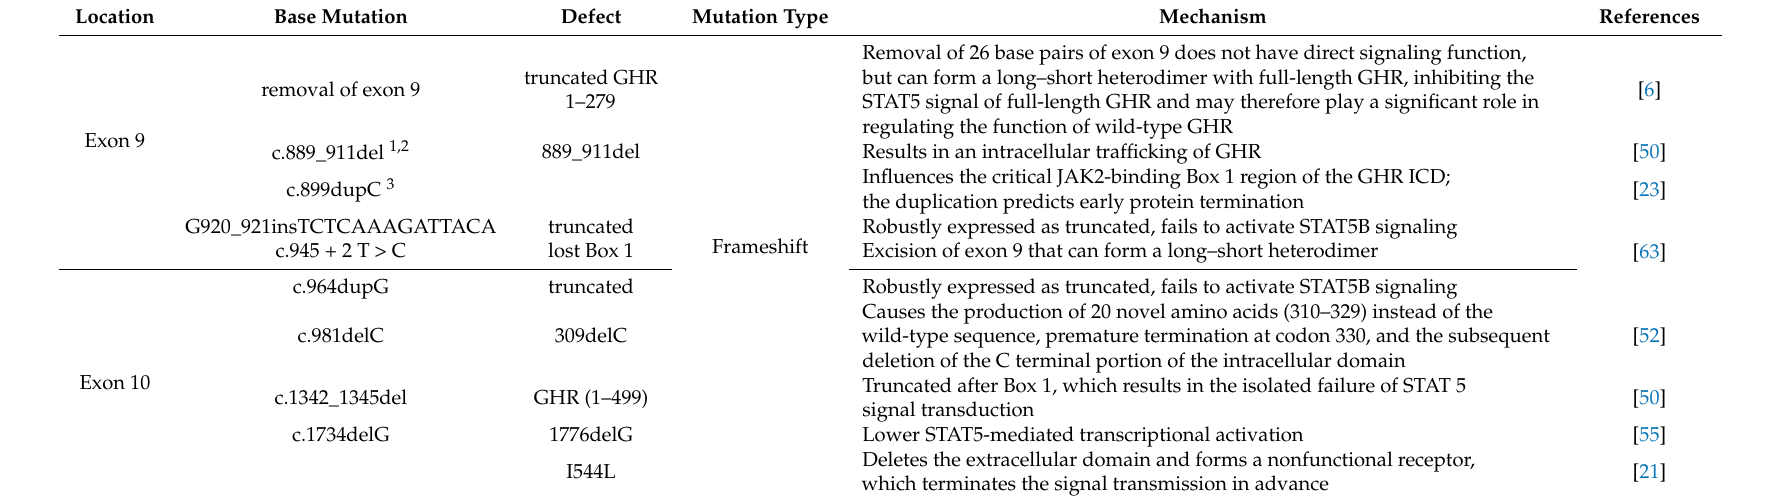
Table 4. Intracellular domain (ICD) mutations of GHR relevant to human dwarfism by preventing GHR downstream